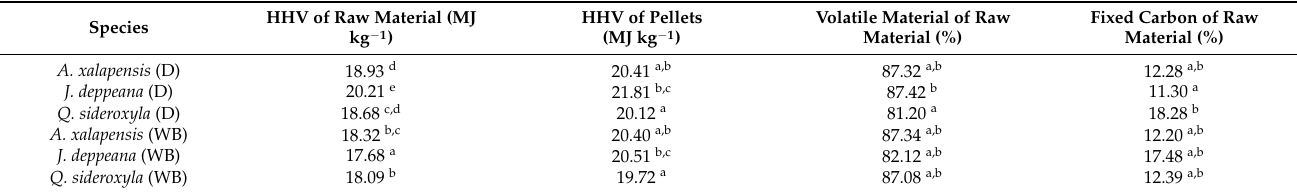
Table 4. Higher heating value and immediate analysis of the three species studied.